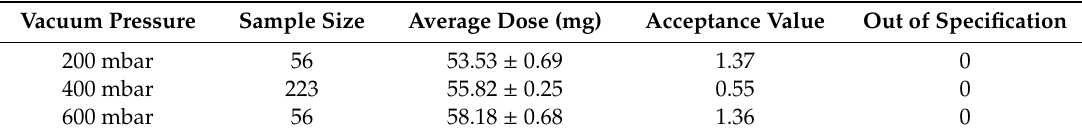
Table1. TheresultsoftheuniformityofdosageunitstestafterdosingwiththeOmnidosefortheisoniazid with 3% trileucine powder at three di ff erent vacuum pressures. Acceptance value (criteria ≤ 15) and the amount of dosage units out of specification are determined according to European pharmacopoeia